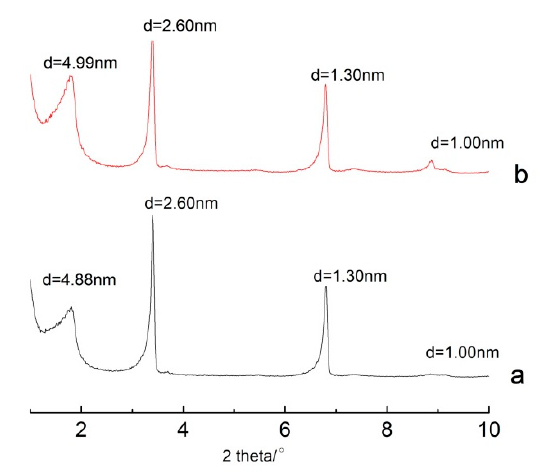
Figure 7. XRD patterns of different raw materials used for the intercalation: a . raw material was S3, CTAB was used as intercalation agent in DMSO solvent; b . raw material was intercalated S3, CTAB was used as intercalation agent in DMSO solvent.